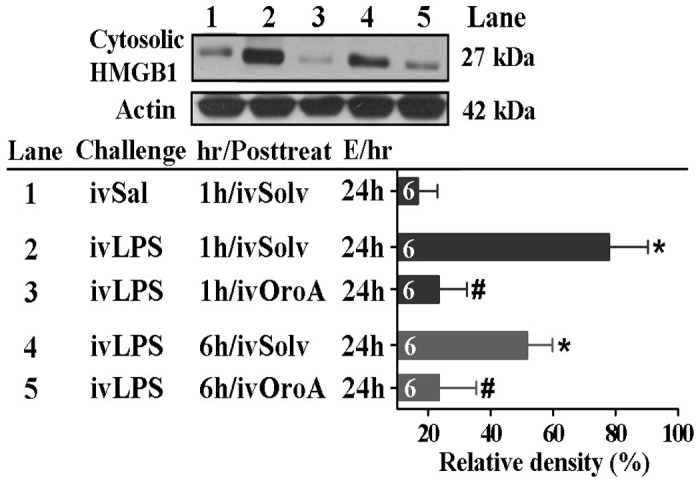
OroA attenuation of LPS-induced HMGB1 release in lung tissue.Comparing to Sal (saline) control (Lane 1), LPS (10 mg/kg, iv) significantly enhanced nuclear HMGB1 release into cytosolic fraction in lung tissue. The increased release was inhibited by OroA (15 mg/kg, iv) administered 1 hr (Lane 3) or 6 hrs (Lane 5) after LPS (Lane 4) challenge. The relative percent of cytosolic HMGB1 protein release was normalized to actin which served as an internal control, and summarized as the relative density (%) of cytosolic HMGB1 expression. Solvent (Solv, normal saline plus Tween 80 at 9∶1 ratio); hr/Posttreat (post-treatment hour after LPS treatment); E/hr (examination hour after LPS challenge). Data are means ± SEM. *P<0.05 indicates significant difference from the normal control (Lane 1). #P<0.05 indicates significant difference from LPS alone (ivLPS-ivSolv in Lanes 2 and 4). The number in each column represents the number of rats examined.